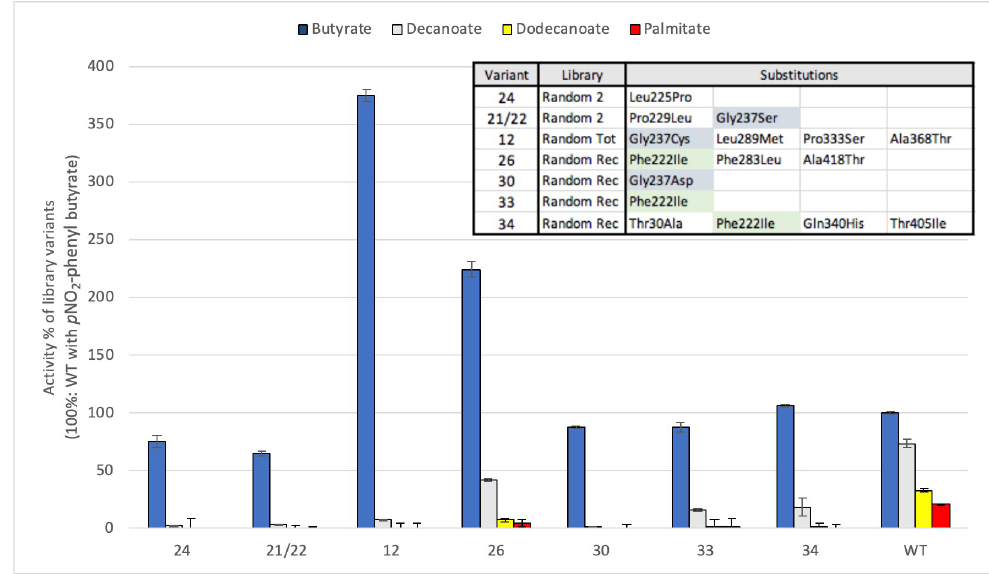
Fig 6. Hydrolytic activity of discriminative variants from randomized libraries with p -NO 2 -phenyl fatty acids. Assays were performed in triplicate with clarified E . coli lysates. Activity is reported relative to WT Cal-A with p NO 2 -phenyl- butyrate. Its specific activity (S.A.) = 0.4 U/mg, is set as 100%. Substitutions included in each variant are inset and recurring mutations are highlighted. Variant number is shown as per S1–S3